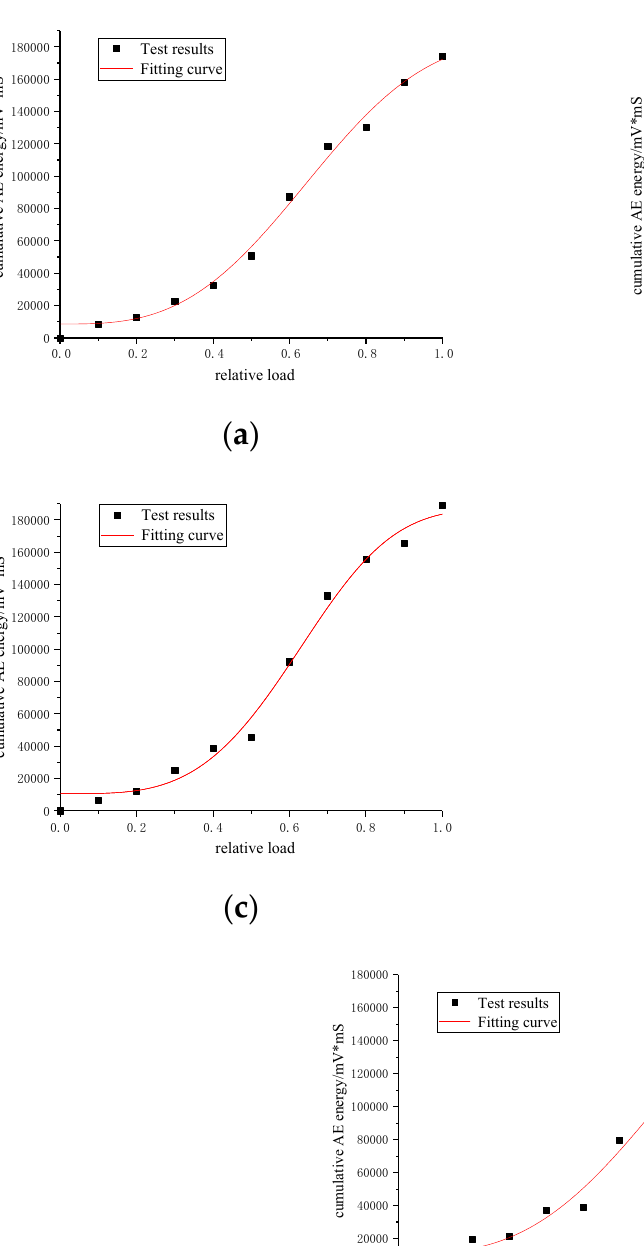
Test piece three; ( d ) Test piece four; ( e ) Test piece five.